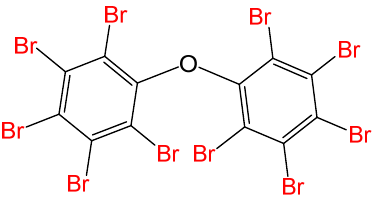
Figure 1. Structure of decabromodiphenylether (DBDE).